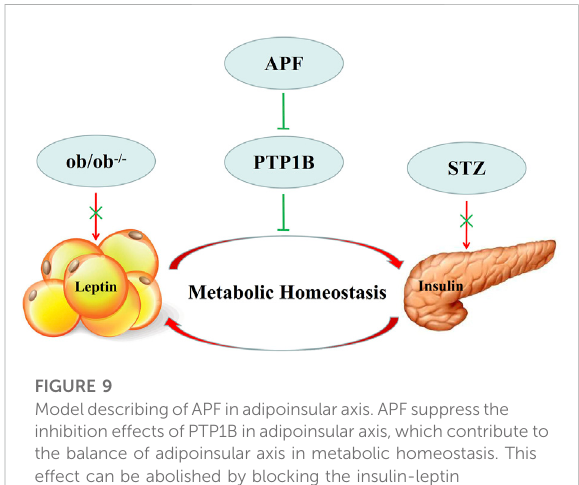
FIGURE 9 ModeldescribingofAPFinadipoinsularaxis.APFsuppressthe inhibition effectsofPTP1Binadipoinsular axis,which contributeto the balance of adipoinsular axis in metabolic homeostasis. This effect can be abolished by blocking the insulin-leptin